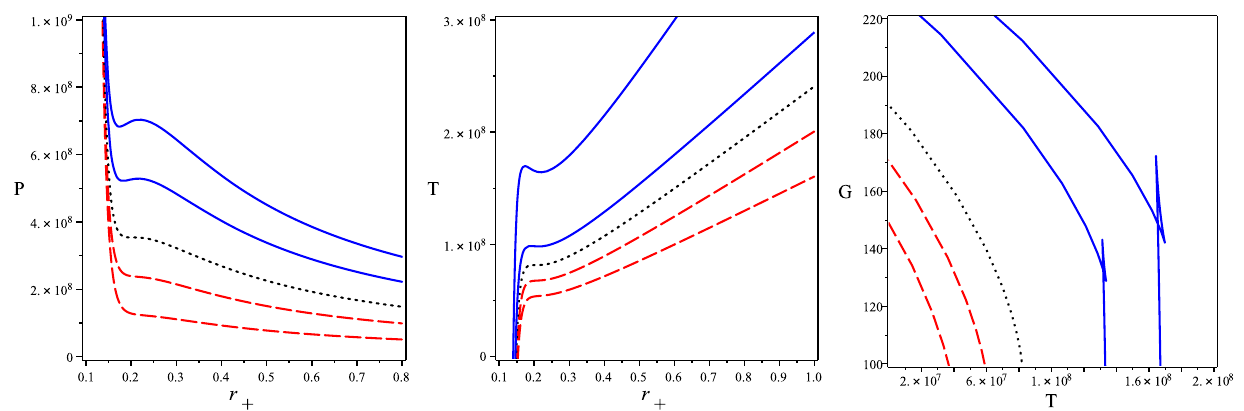
Fig. 20 Hot hyperbolic black hole in LM gravity: P − r + (left), T − r + (middle) and G − T (right) diagrams; we have set k = − 1, d = 8, q = 1, m = 1, c 0 = c 1 = c 2 = c 3 = c 4 = 1 and α = 0 . 01. Left